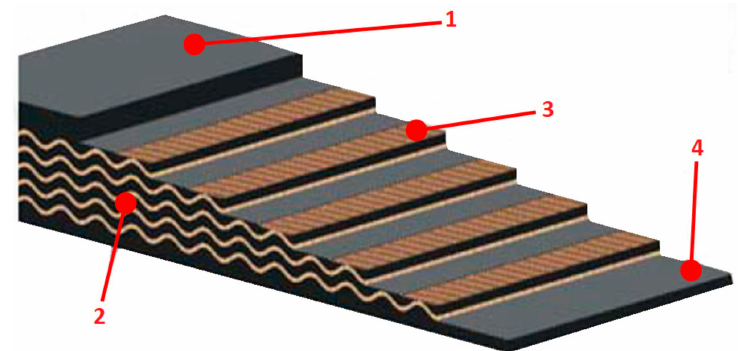
Figure 1. Fabric conveyor belt structure: (1) top cover layer; (2) carcass; (3) fabric ply; (4) bottom cover layer [25].